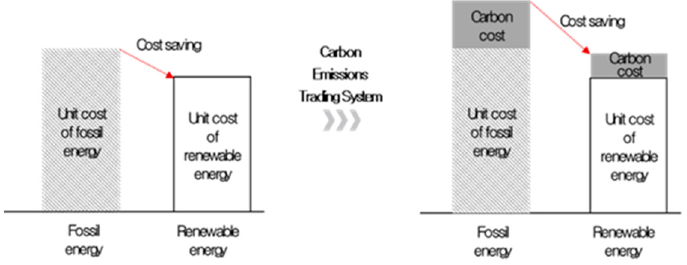
Figure 1. Cost reduction structure after carbon market introduction.